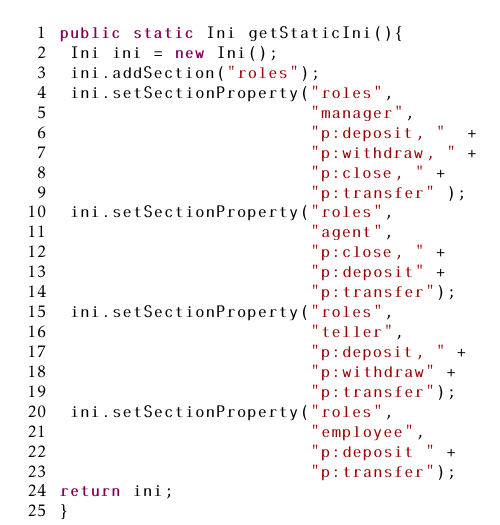
Figure 12. Introducing mutants inan ApacheShiroconfiguation.